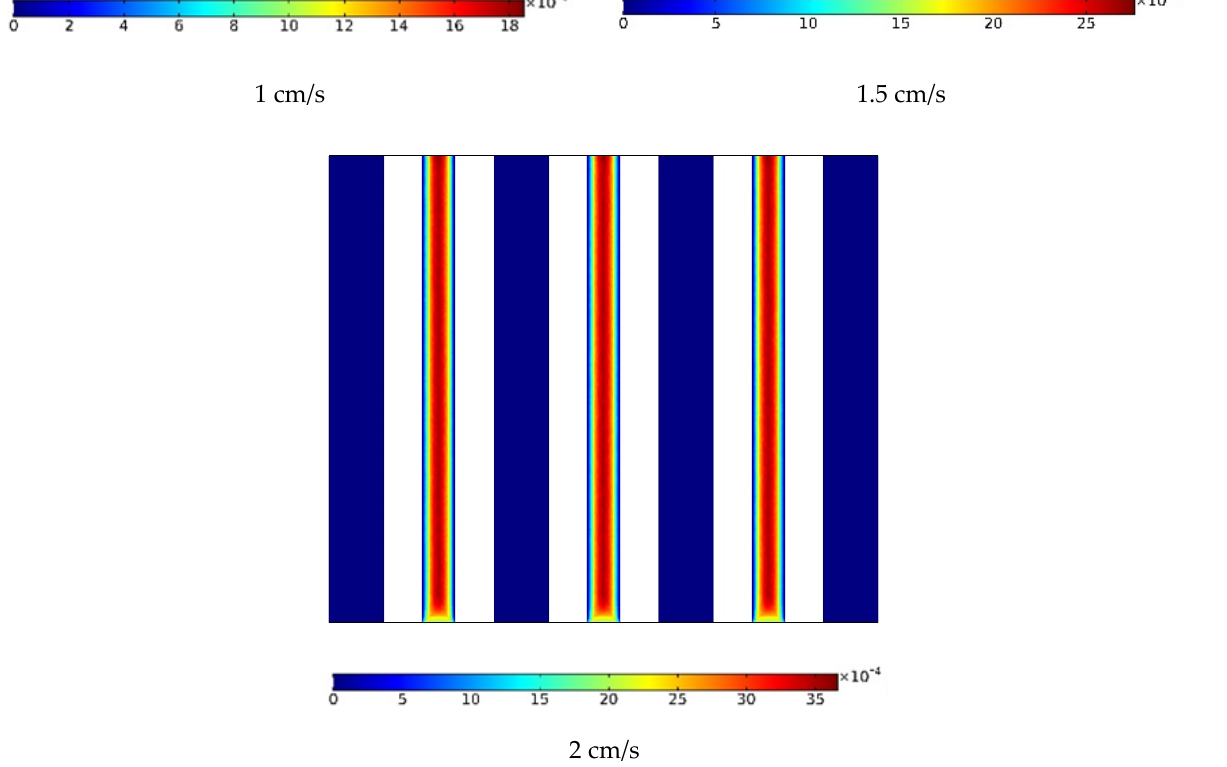
Figure 6. The velocity in the horizontal middle section at three velocities.